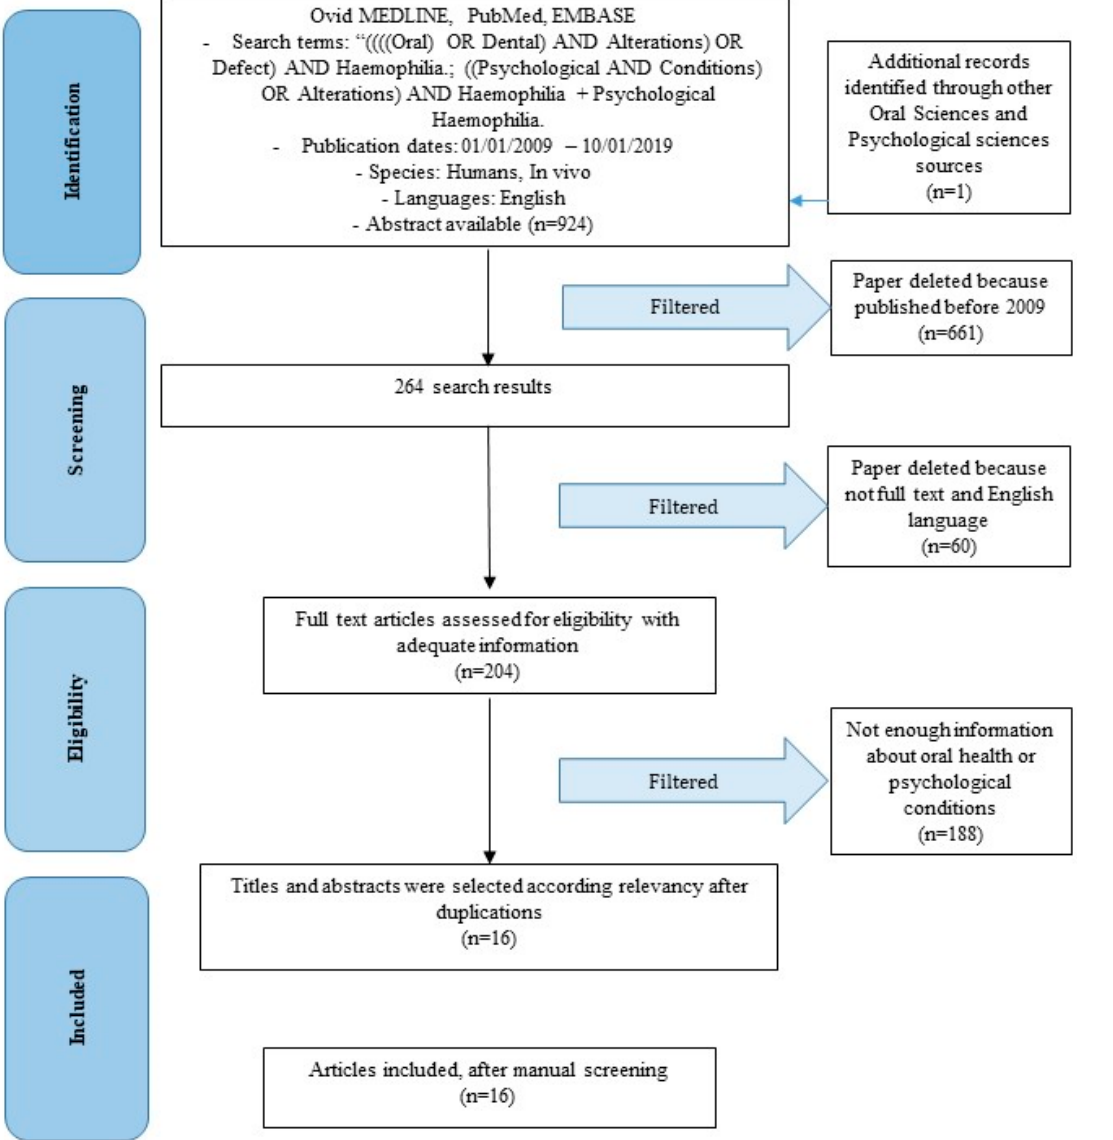
Figure1. Figure 1. Preferred Reporting Items for Systematic Reviews and Meta-Analyses (PRISMA) flow diagram.